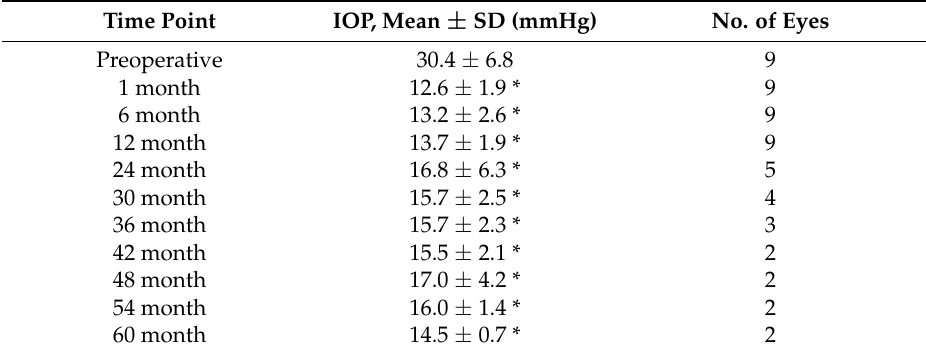
Table 2. Mean post-operative intraocular pressure (IOP).